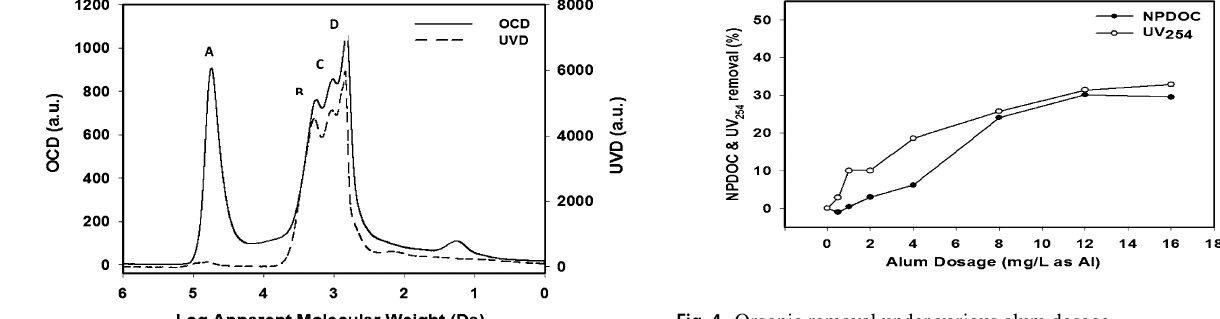
Fig. 4 Organic removal under various alum dosage